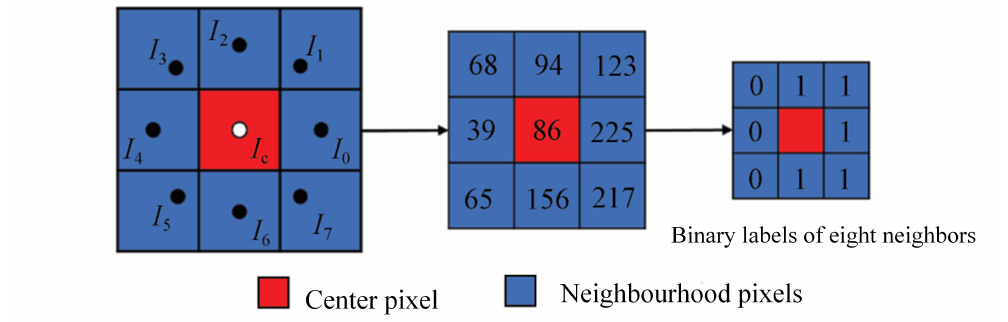
Figure 5. Example of LBP binary